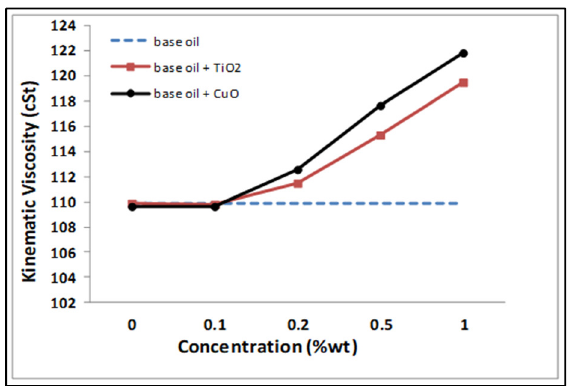
Fig. 5. The kinematic viscosity of nano-lubricants at 40 °C.